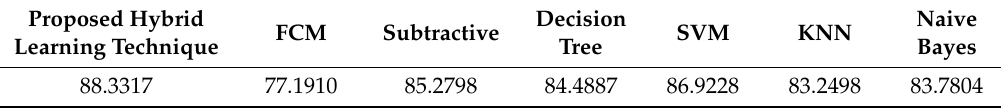
Table 3. Overall performance of tested techniques with